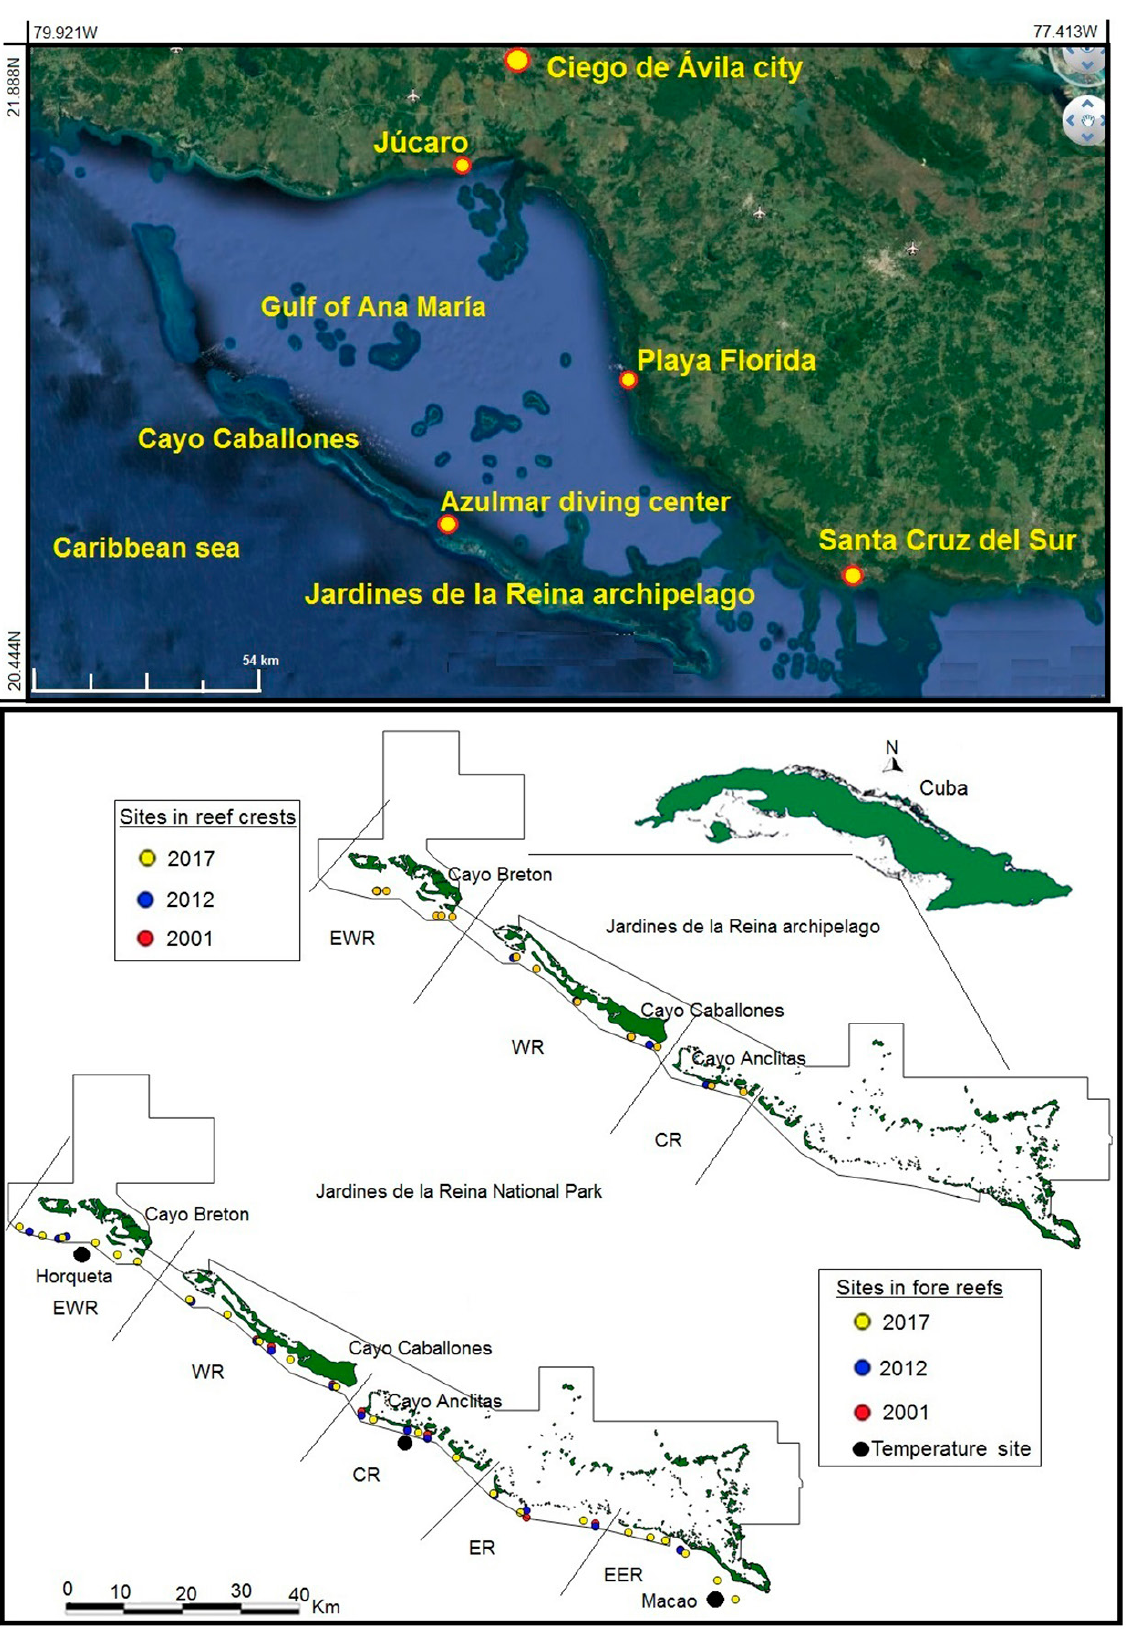
Fig. 1. – Study area. Sampling sites per year. Zones of the JRNP (EWR, Westernmost Reserve; WR, Western Reserve; CR, Central Reserve; ER, Eastern Reserve and EER, Easternmost Reserve). Horqueta, Anclitas and Macao: sites where average monthly temperature was